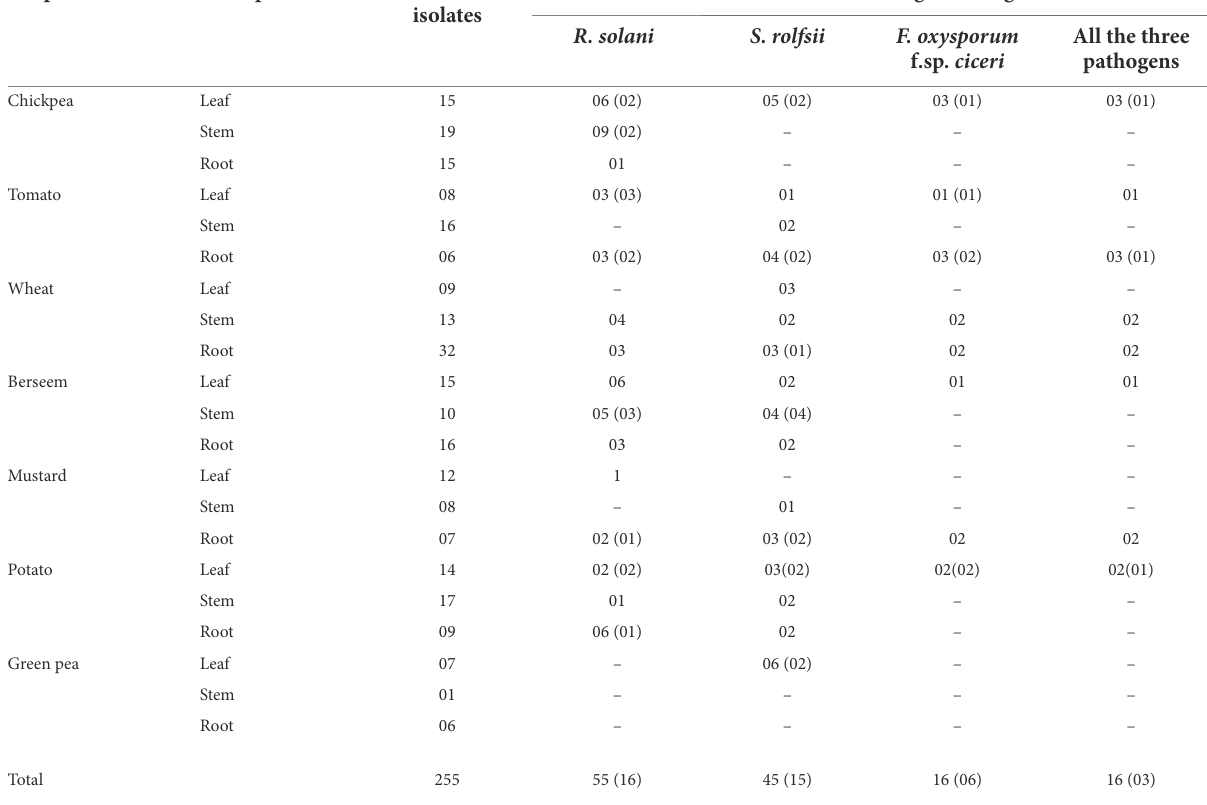
TABLE 2 Screening of bacterial endophytes against soil-borne fungal pathogens.